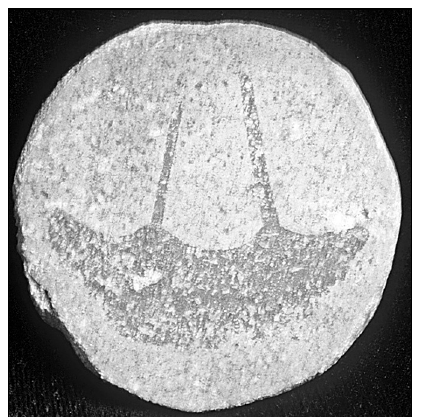
features that indicate reed-bundle construction are beginning to be